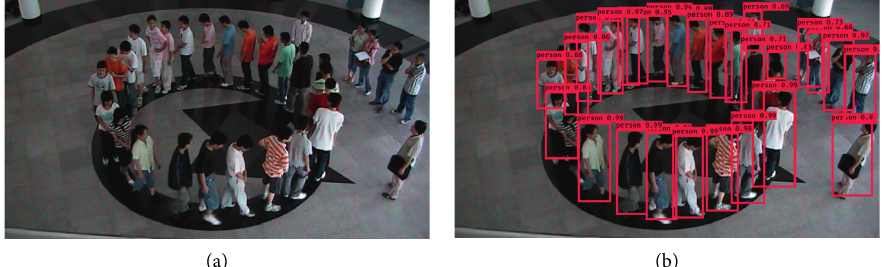
Figure 2: The images of one simple pedestrian flow experiment under circular boundary conditions. It was conducted at 2014. (a) The original image. (b) The results detected by the pretrained Yolo